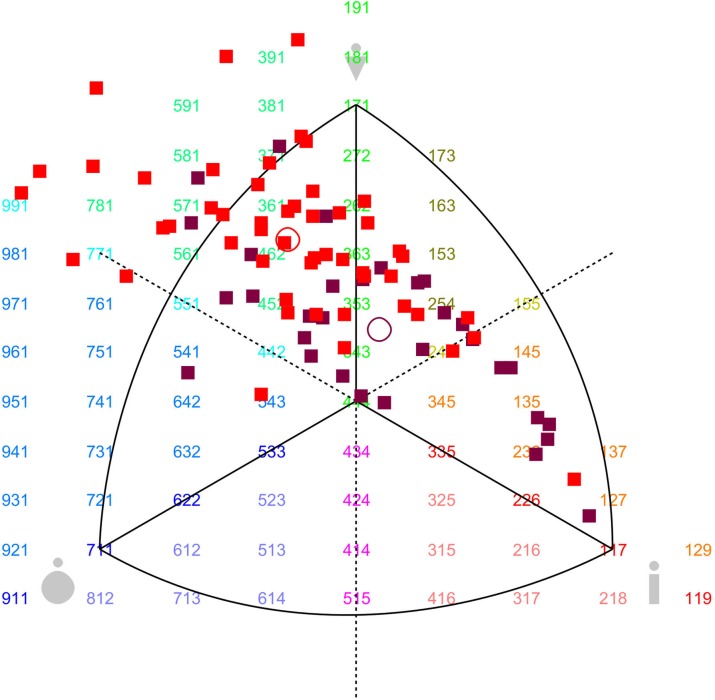
Somatotype profiles of male candidates as models for the BSS.In somatocharts, mesomorphy is represented by the vertical axis pointing upward; endomorphy by the horizontal axis pointing to the left; and ectomorphy by the horizontal axis pointing to the right. The red squares represent Cameroonian males and the purple ones Senegalese males. The red circle indicates the mean profile for Cameroonians and the purple one the mean profile for Senegalese.